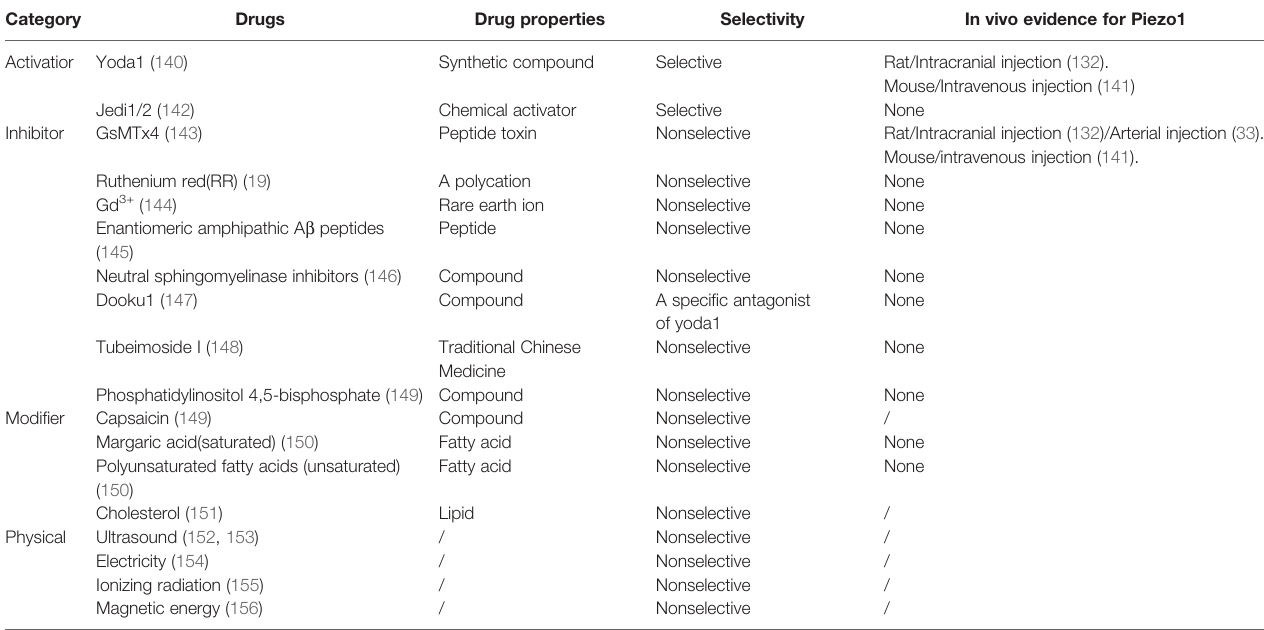
TABLE 2 | Currently reported drugs and physical methods can regulate